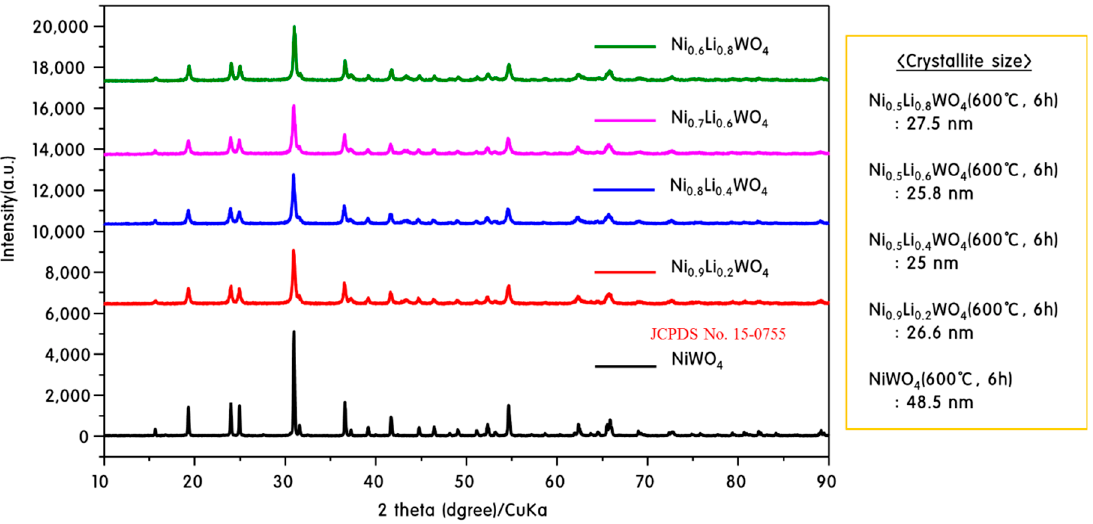
ff raction patterns of Ni Figure 1. X-ray diffraction patterns of Ni 1-x Li 2x WO 4 particles. Figure 1. X-ray di